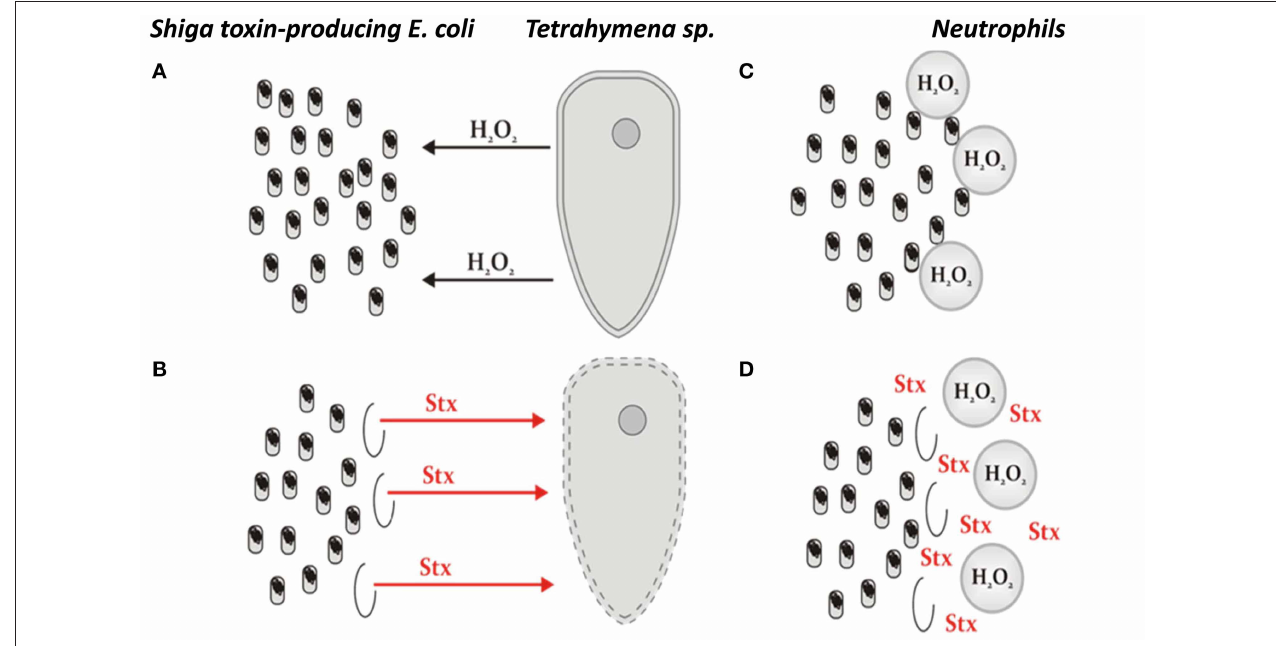
FIGURE 1 | The model of STEC altruism, representing the hypothesis on the benefit which E. coli lysogenic with Shiga toxin-converting phages may gain from production of Shiga toxins coupled with prophage induction and subsequent cell death. (A) A protozoan predator (exemplified by Tetrahymena ) releases hydrogen peroxide to damage bacterial cells. (B) In the case of STEC, hydrogen peroxide causes induction of Shiga toxin-converting prophage in a small fraction of bacterial cells, which